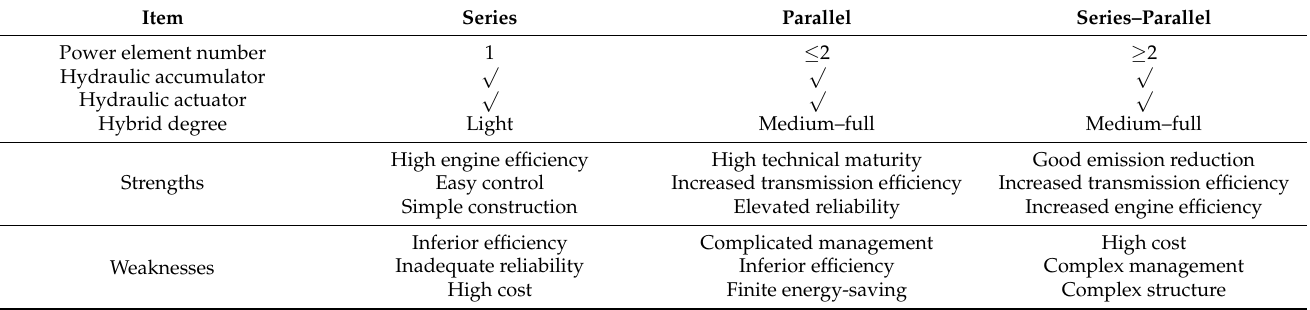
Table 2. Summary of the configuration characteristics of the hybrid hydraulic vehicles.